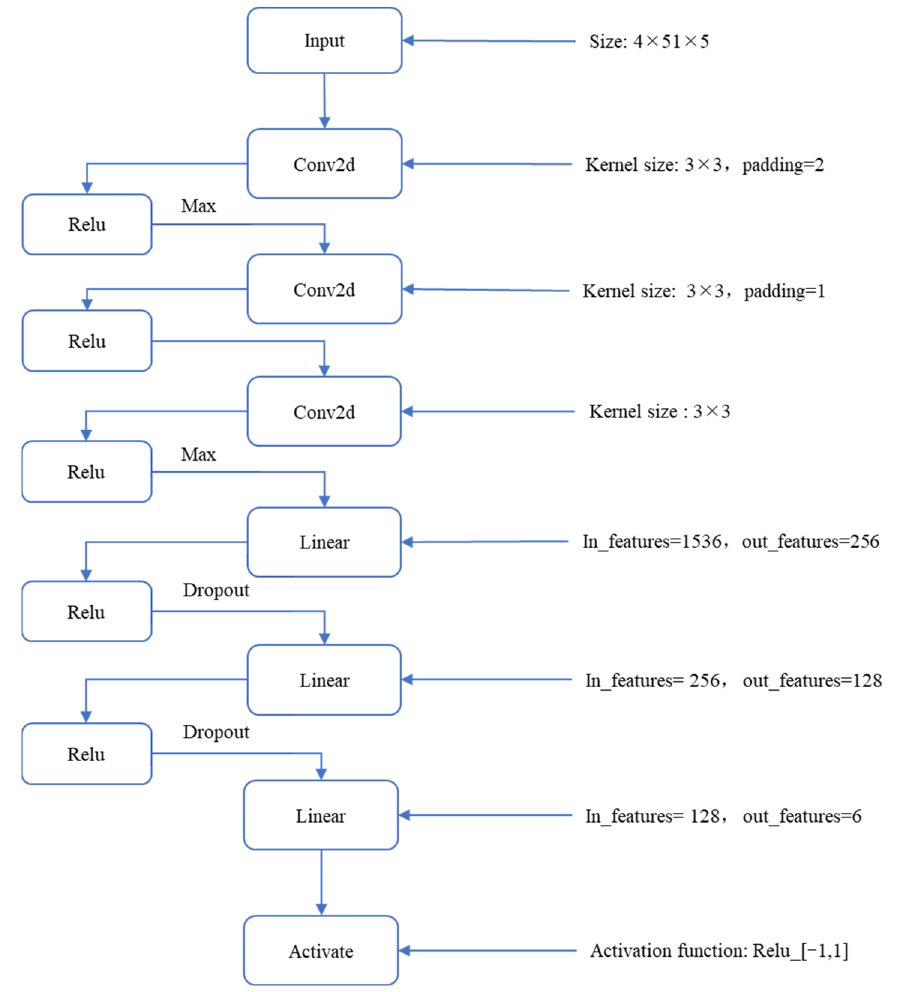
Figure 8. The neural network structure of actor.